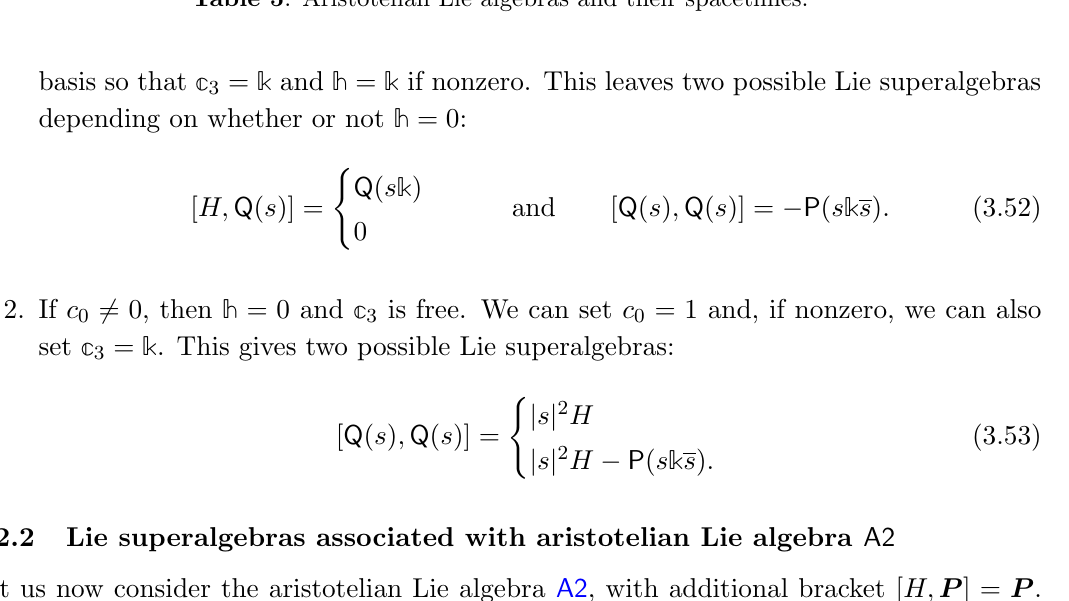
Table 5 . Aristotelian Lie algebras and their